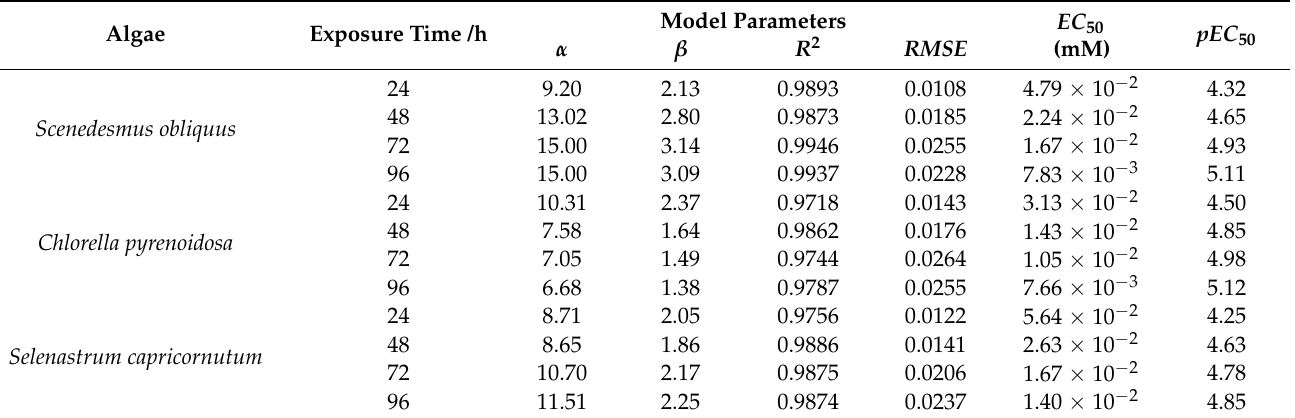
Table 1. α and β values of the Weibull functions, fitting results ( R 2 and RMSE values), EC 50 values, pEC 50 values, and other parameters for Cd at four time points.